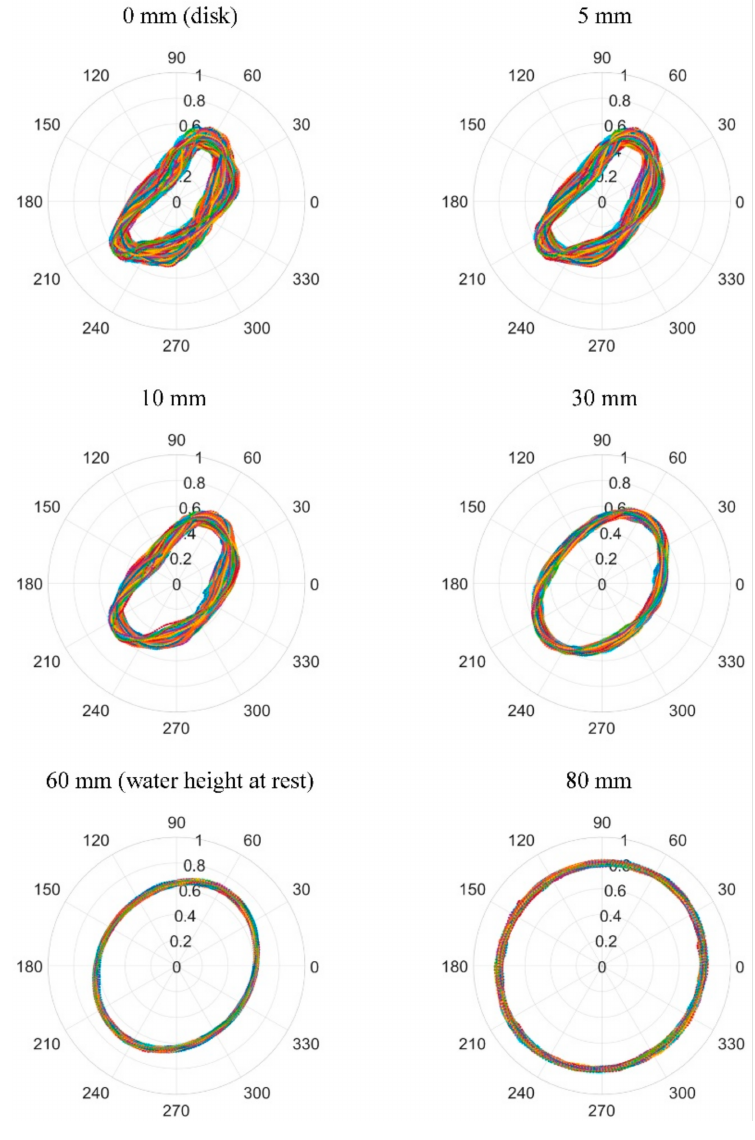
Figure 6. Free surface contours at six heights for 3.4 Hz disk rotation frequency. Each contour is rotated to the contour of t = 0 s using maximum correlation between the shapes. For each height 1085 contours are plotted representing results for 108.5